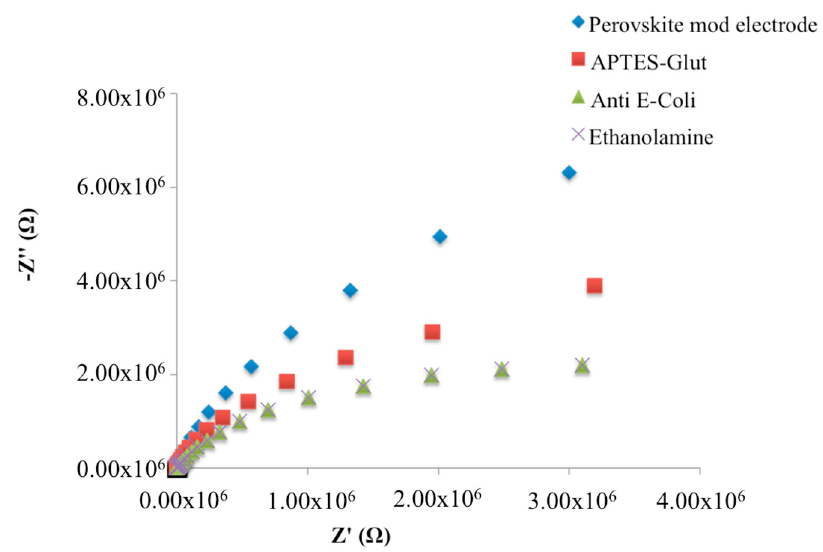
Figure Figure 3. Nyquist plots in non-faradaic impedance measurements during the fabrication of the immunosensor.